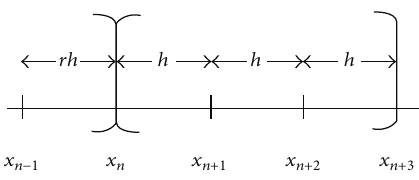
Figure 1: Three-step Adam’s